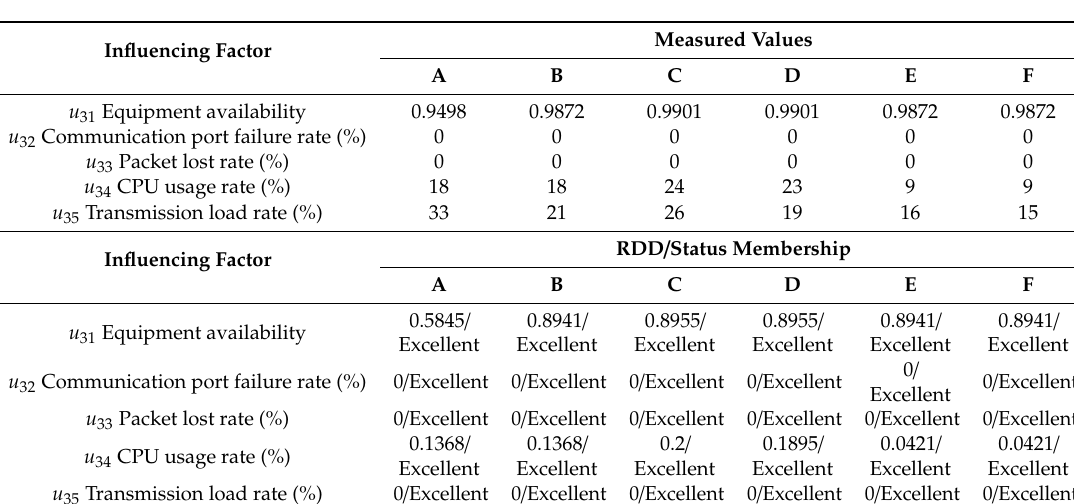
Table 6. Switches status data.